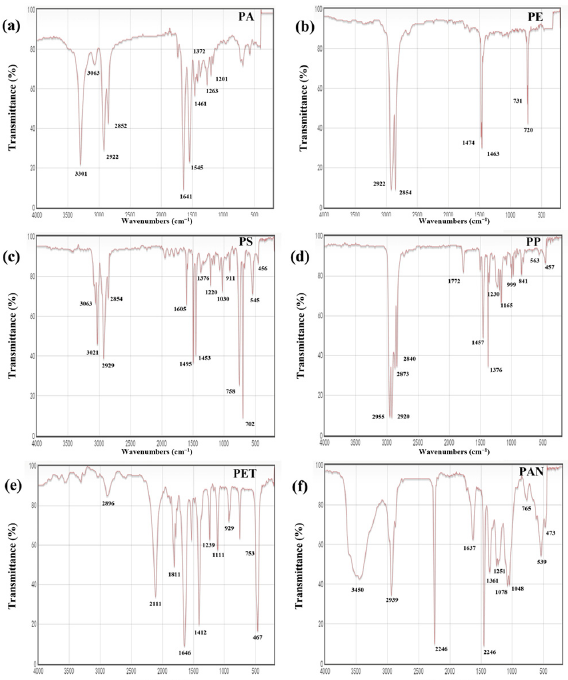
Figure 5. The standard FT-IR spectra of the predominant microplastics. ( a ) PA; ( b ) PE; ( c ) PS; ( d ) PP; ( e ) PET; and ( f ) PAN.